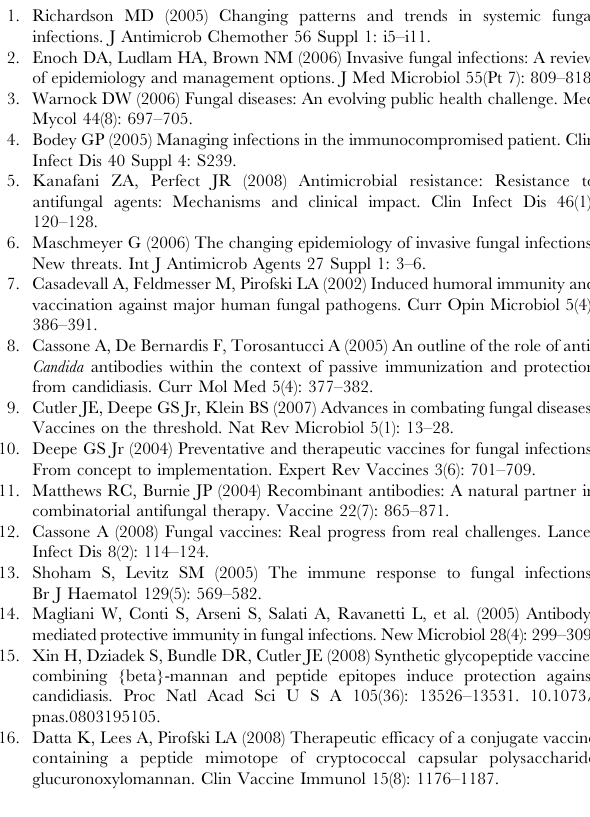
Figure S2 SDS-PAGE and Western blot analysis of IgG mAb- reactive material purified by immunoaffinity from hyphal secretion. Lane 1 and 2 show silver staining of the total hyphal secretion and the IgG mAb-immunopurified fraction, respectively. Lane 3 and 4 shows Western blot reactivity of the immunopurified fraction with the IgG mAb (Lane 3) or with the IgG fraction of a protective serum from mice immunized with the Lam-CRM vaccine (see text). Found at: doi:10.1371/journal.pone.0005392.s002 (3.72 MB